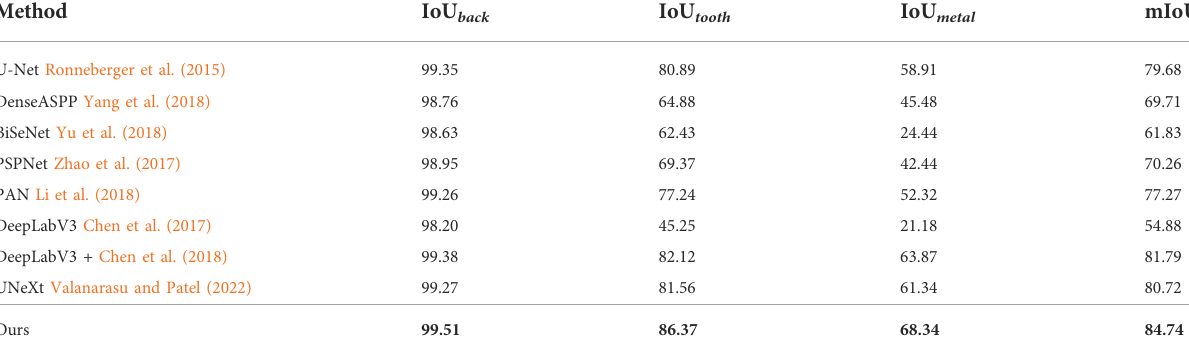
TABLE 1 Segmentation comparison among our method and other state-of-the-art methods on the COVID-19 dataset.